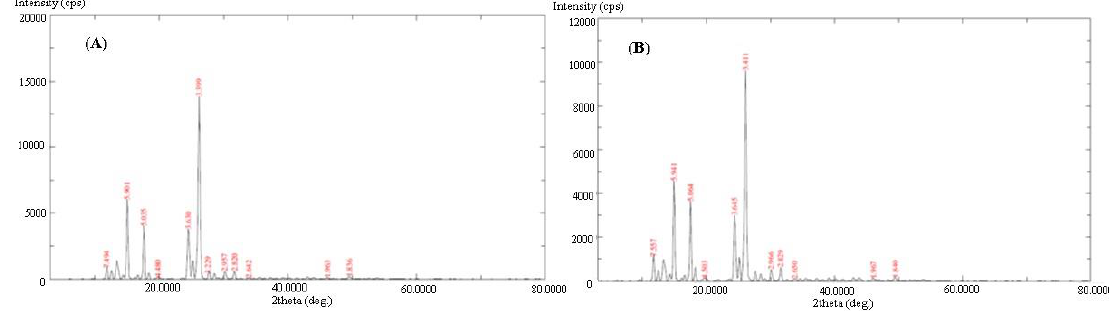
Figure 3. The PXRD spectra of ( A ) pure PPD and ( B ) equilibrated PPD; equilibrated PPD was recovered from methanol after slow evaporation.